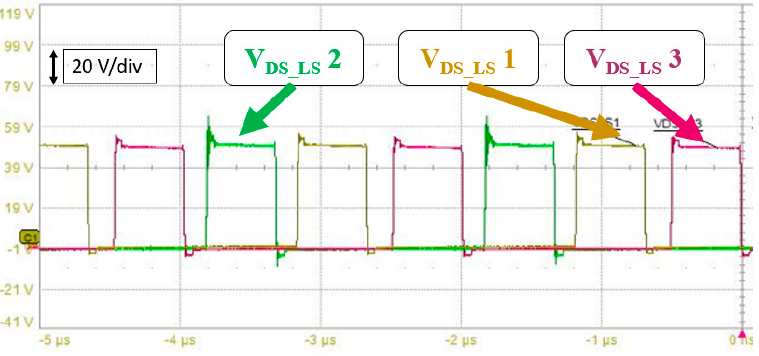
Figure 11. V DS for the low side of each leg of the three-phase converter, with the proper phase